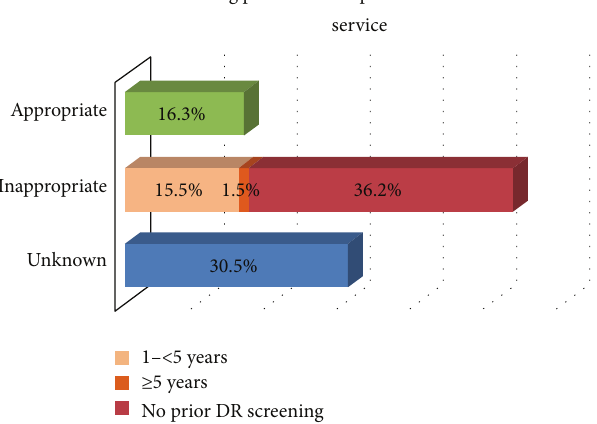
Figure 4: Patient reported DR screening prior to the implementa- tion of the model ( 𝑛 = 141 ). Note: unknown included those patients who were not aware if they had undergone screening previously and those who had undergone screening but were unsure of the date.